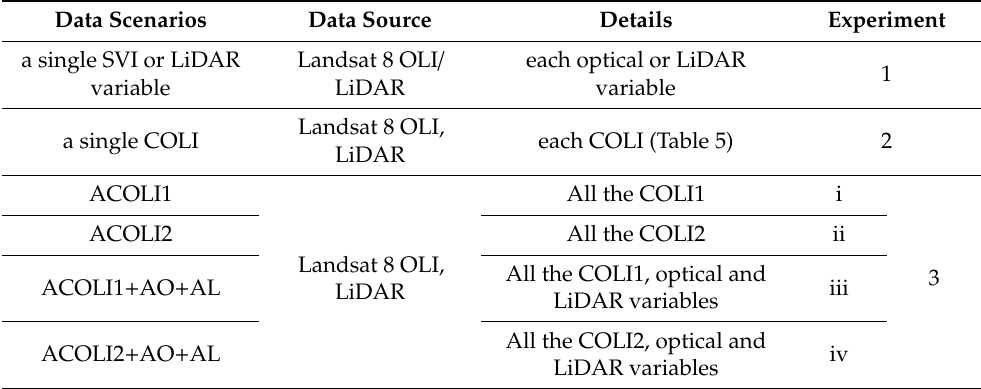
Table 2. Predictor variables used in each data scenario for modeling